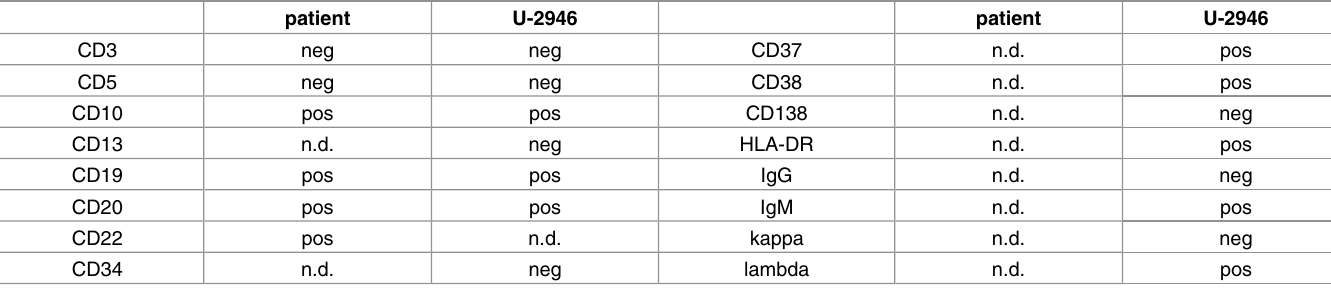
Table 1. Immunoprofile of patient and–derived cell line